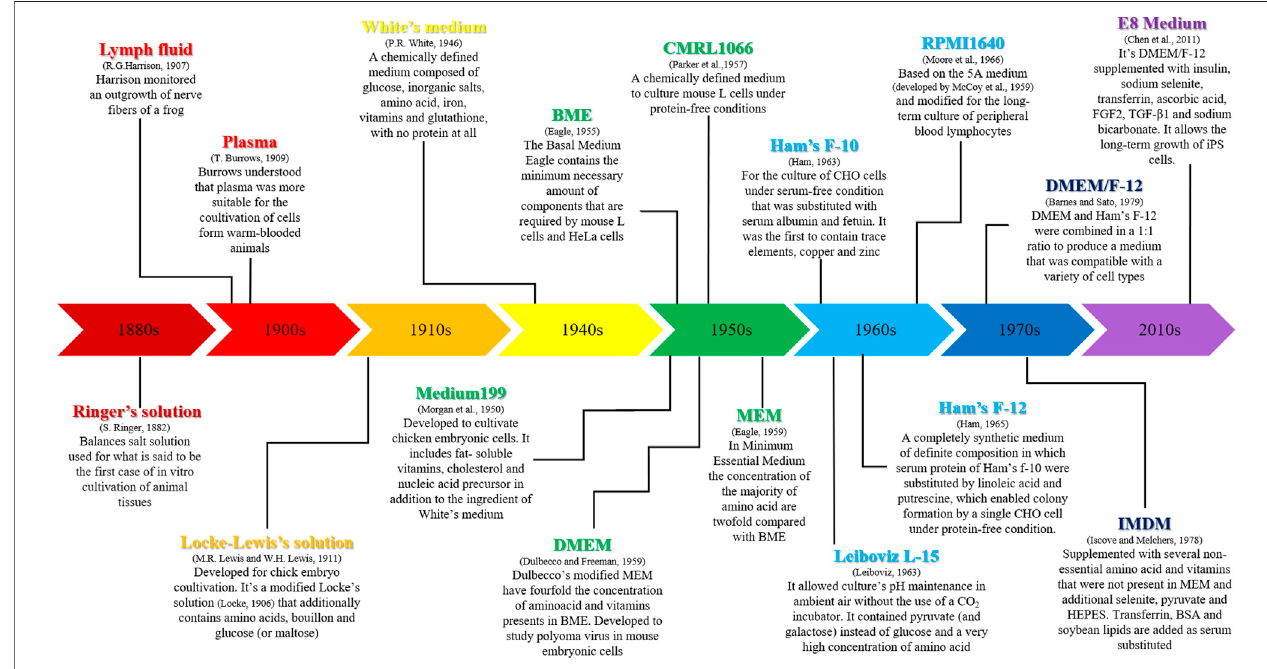
FIGURE 1 | Development and applications of the main media used for cell